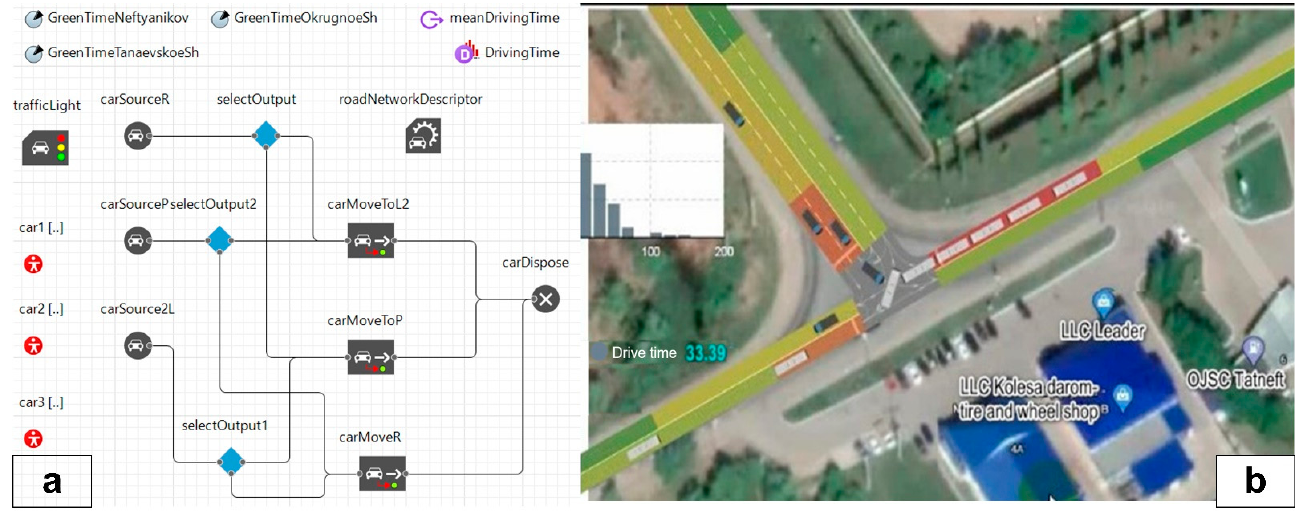
Figure 6. ( a ) The SM structure; ( b ) SM of the road network section before the changes.